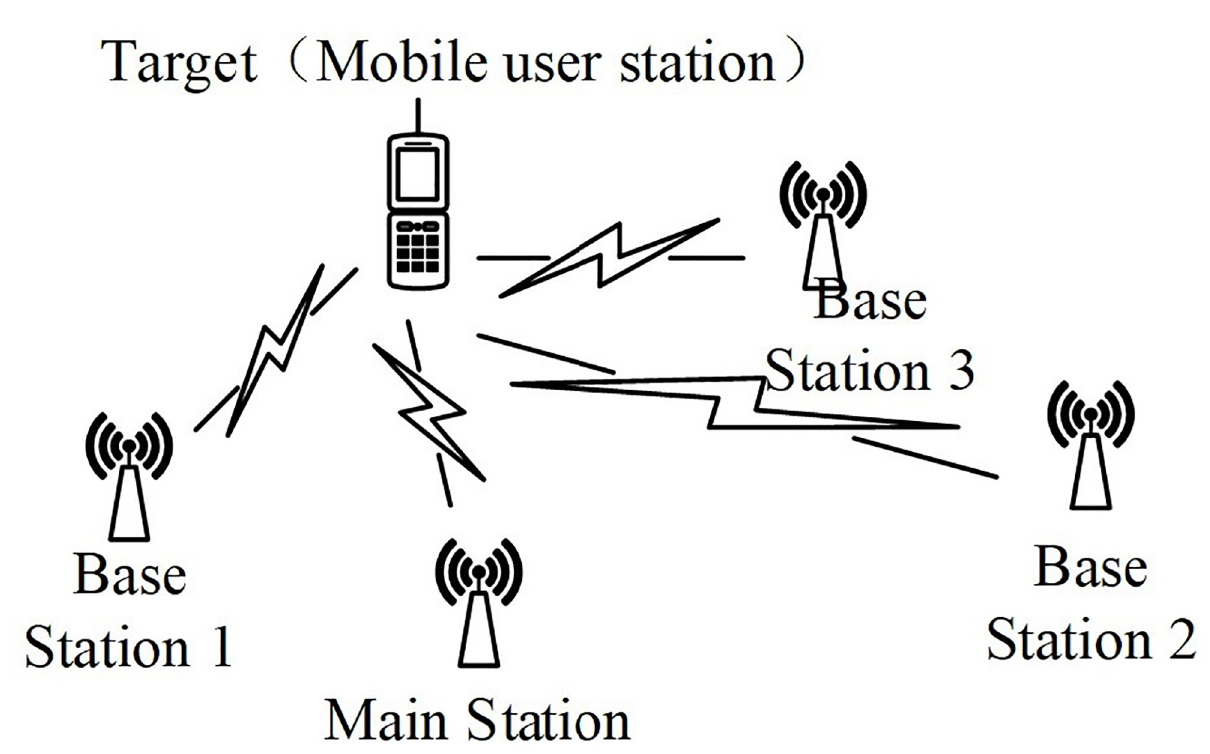
Fig 3. Schematic diagram of TDOA positioning